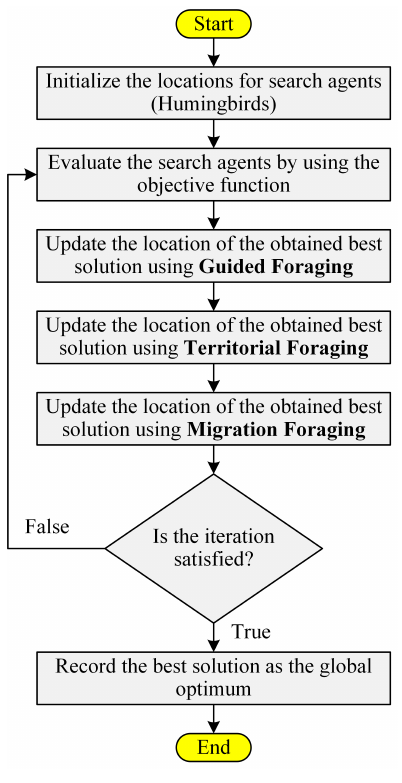
Figure 2. Schematic flowchart of